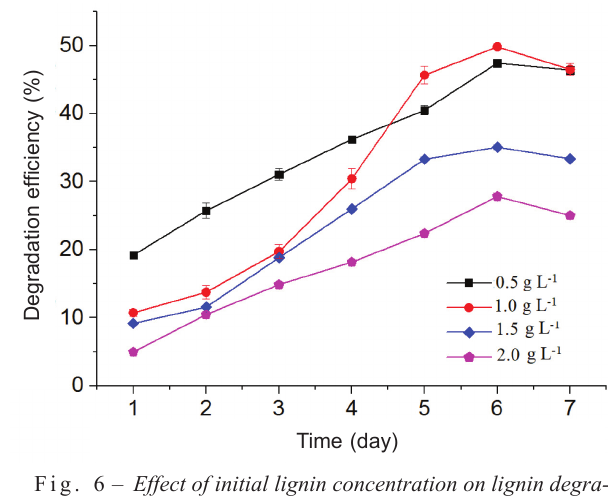
Fig. 6 – Effect of initial lignin concentration on lignin degra­ dation (shaking speed = 160 rpm, inoculation amount = 5 %, temperature = 35 °C, pH = 7)